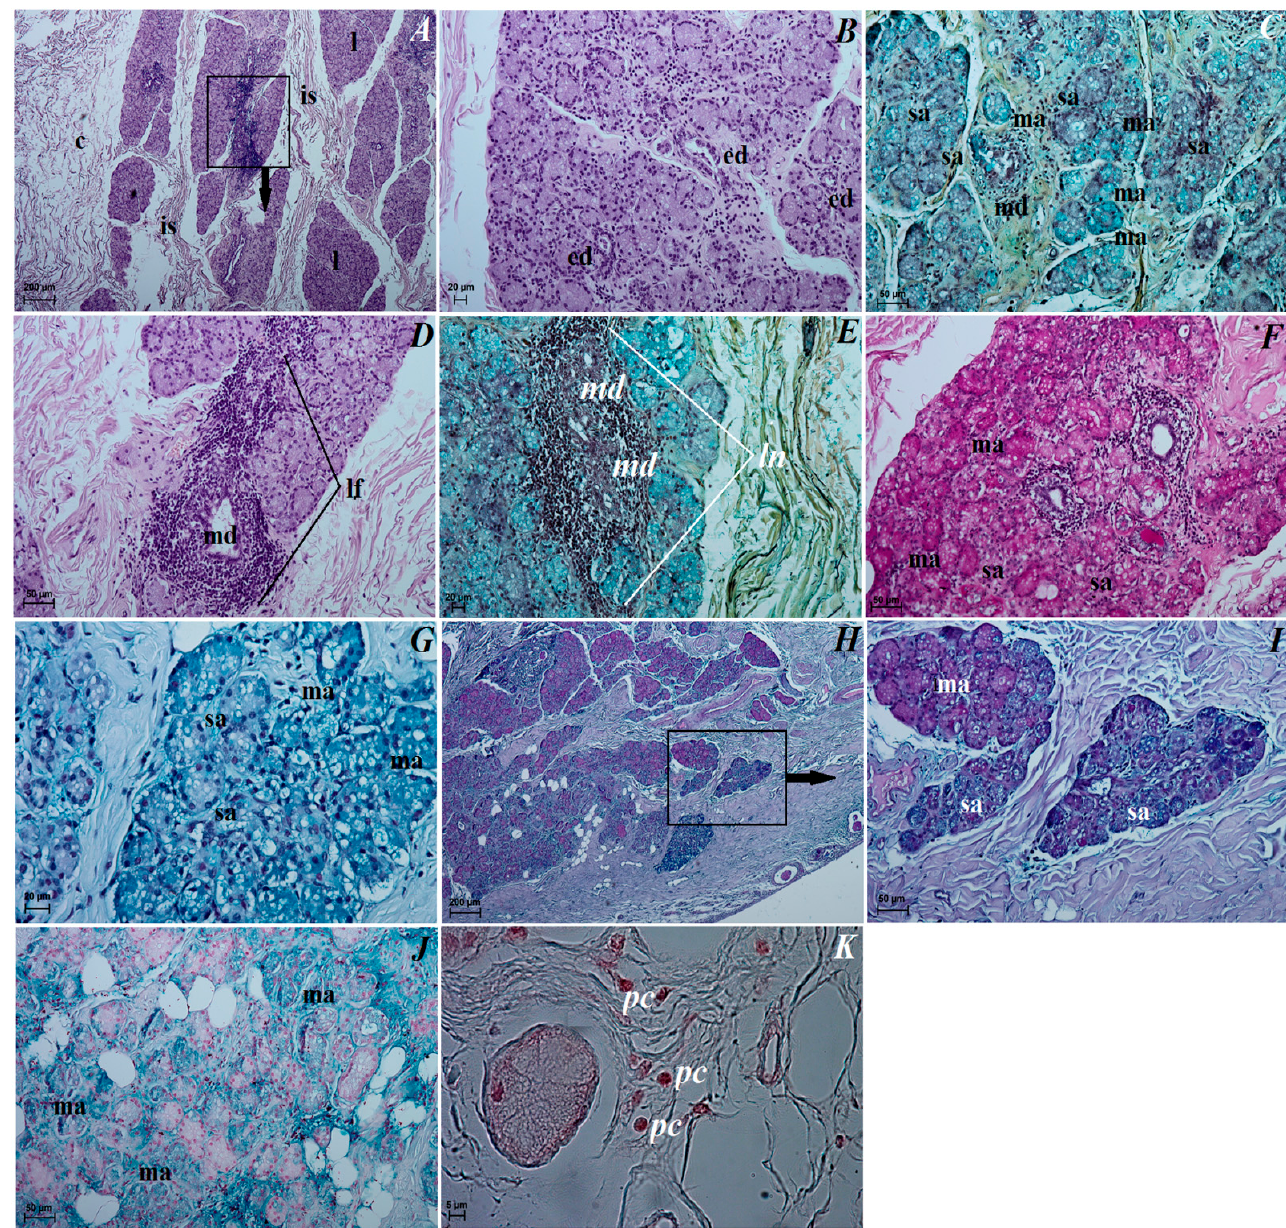
Figure 6. Photomicrograph of the Ursus thibetanus superficial gland of the third eyelid. ( A , B , D ) = H&E; ( C , E ) = Movat pentachrome stain; ( F ) = PAS strongly (+++) positive reaction in the mucous acini and slightly ( − /+) positive reaction in the serous acini; ( G ) = AB pH 2.5 slightly ( − /+) positive reaction in the mucous and serous acini; ( H , I ) = AB pH 2.5/PAS middle (++, magenta color—neutral mucins) in the mucous acini and weakly positive reaction (+, blue color—acidic sulfated mucosubstances and sialomucins) in the serous acini; ( J ) = HDI middle (++) positive reaction in the mucous acini and HDI negative ( − ) reaction in the serous acini; ( K ) = MGP Y stain. c—capsule, ed—excretory duct, is—interlobar septa, l—lobes, ln—lymphatic tissue, lf—lymphoid follicles, ma—mucous acini, md—main duct, pc—plasma cells, sa—serous acini. Scale bars: ( A , H ) = 200 µ m; ( C , D , F , I , J ) = 50 µ m; ( B , E , G ) = 20 µ m; ( K ) = 5 µ